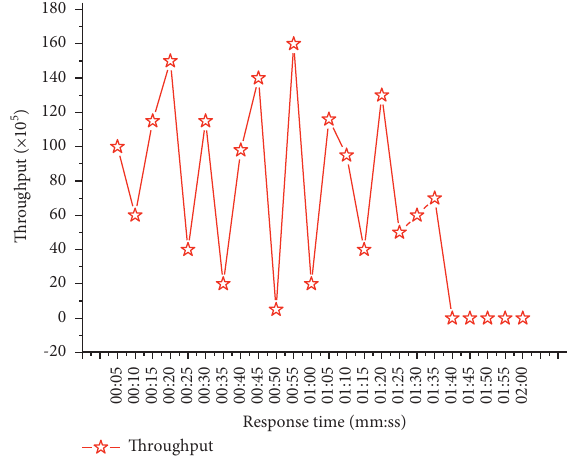
Figure 7: Test results of the throughput